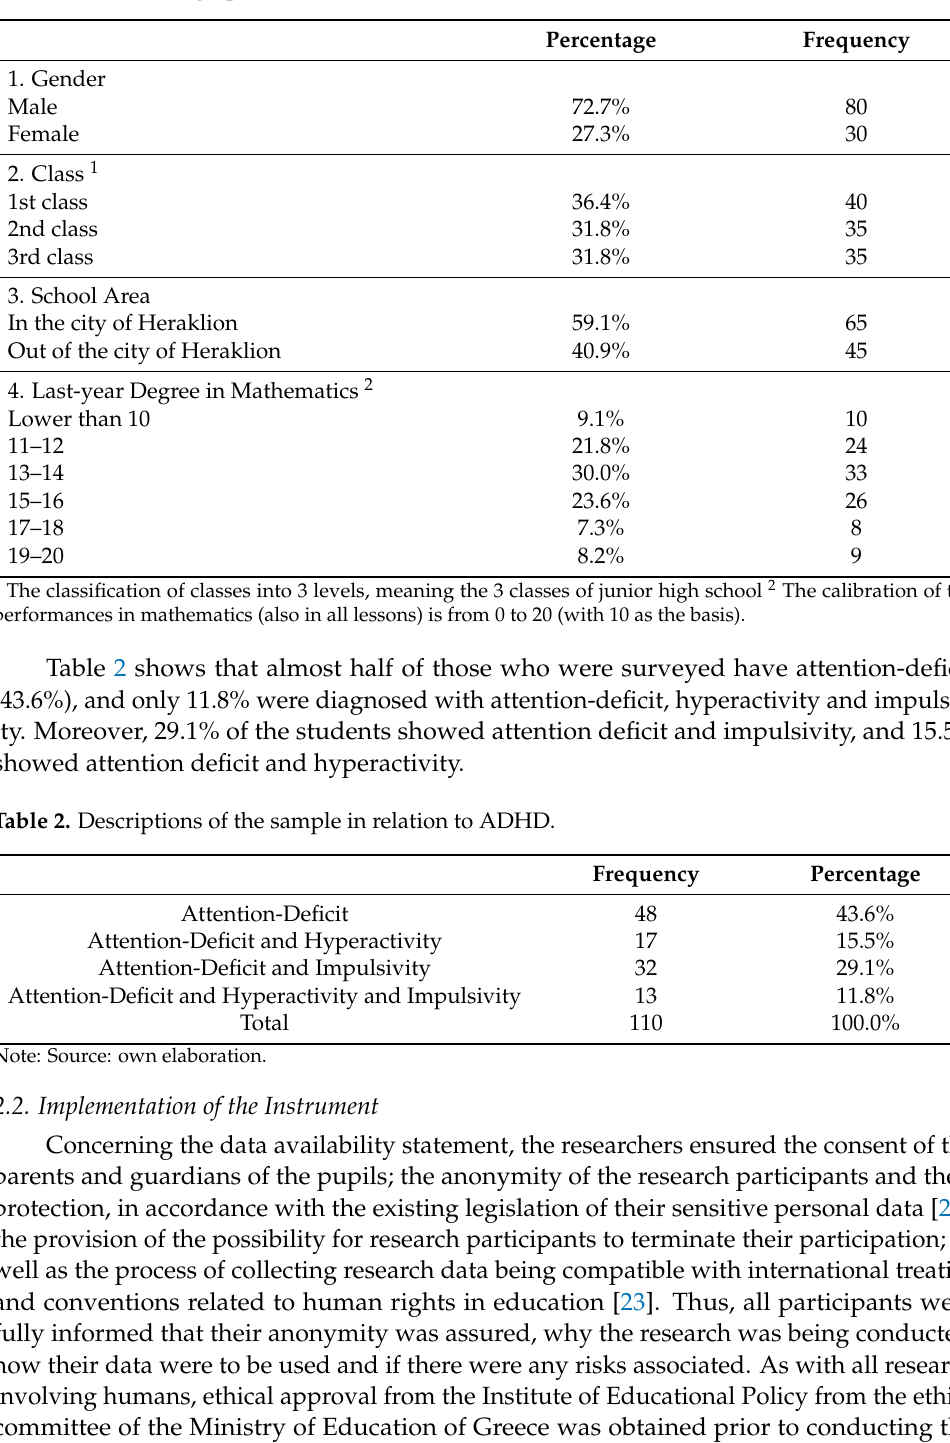
Table 1. Socio-demographic variables.